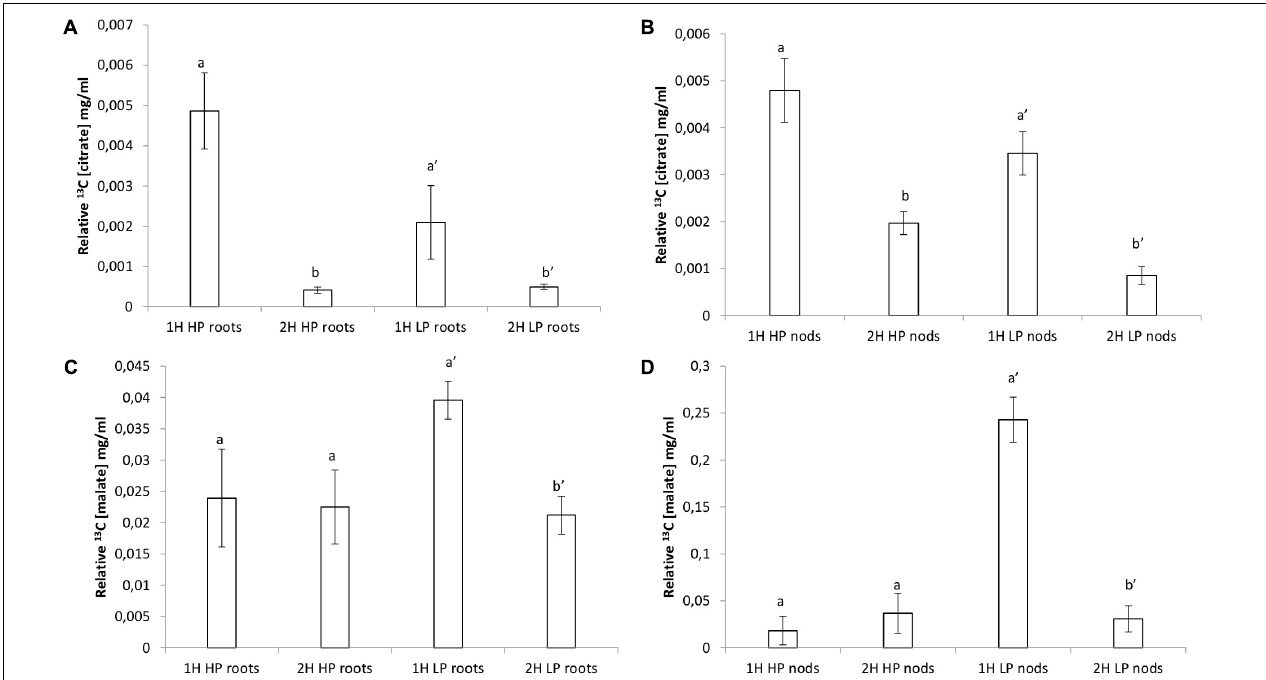
FIGURE 6 | Relative organic acid concentrations (mg.ml − 1 ) found by 13 C NMR analysis in roots and nodules of V. divaricata , grown under high phosphate (500 µ M P) and low phosphate (5 µ M P) conditions (A) root malate, (B) nodule malate, (C) root citrate, (D) nodules citrate.